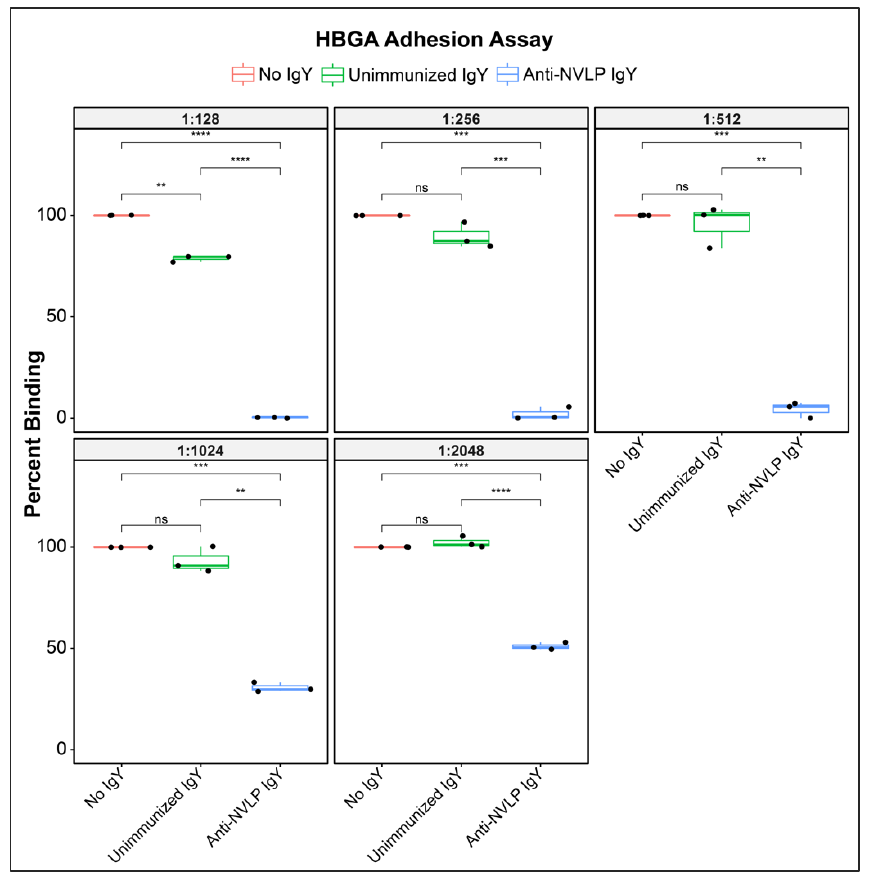
Figure 1. Box and whisker plots of inhibition of HuNoVLP adhesion to HBGA antigens in a cell-free system. Boxes represent interquartile range (IQR) with median, shown as center bar of each sample group (N = 3 replicates per group). Whiskers represent 1.5 times the IQR. p -value, by two-sample t-test method, and 95% confidence interval (CI) was calculated using R software package EnvStats (v.2.3.1) [28]. (ns), not significant, p > 0.05; (*), p ≤ 0.05; (**), p ≤ 0.01; (***), p ≤ 0.001; (****), p ≤ 0.0001.